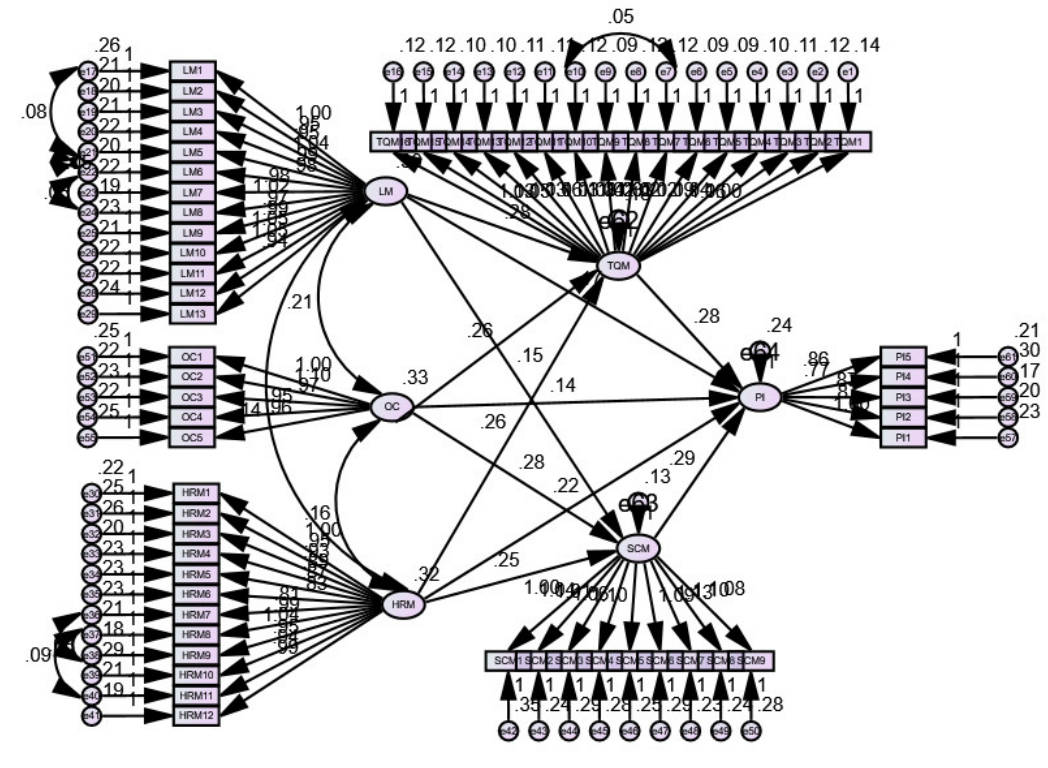
Figure 3. The structural model.